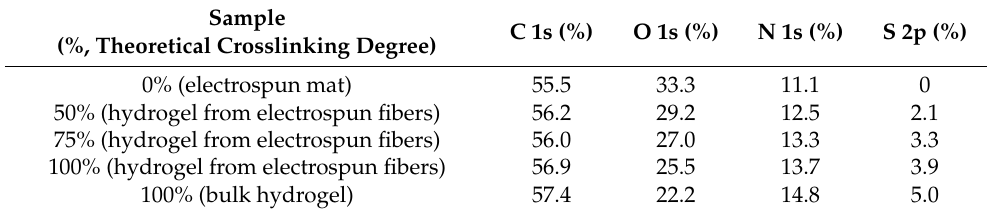
Table 1. Atomic percentages deduced from XPS spectra of electrospun hydrogels with different theoretical crosslinking percentages, electrospun mat and bulk hydrogel with a theoretical 100% crosslinking